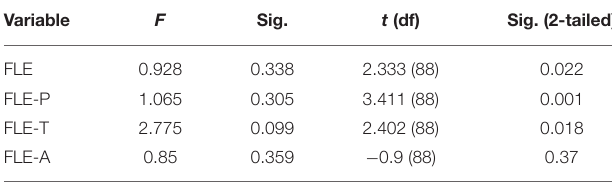
TABLE 9 | Independent t- test for FLE, FLE-P, FLE-T, and FLE-A between learners who were and were not in China ( N = 90, Yes = 20, No =